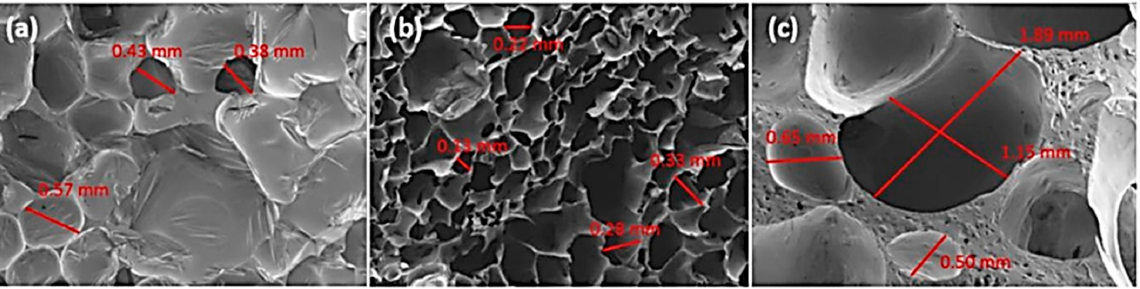
Figure 12. SEM images of ( a ) 80:20, ( b ) 60:40, and ( c ) 50:50 (weight ratio castor oil polyol: wheat straw derived biopolyol) and TDI foams [98] .